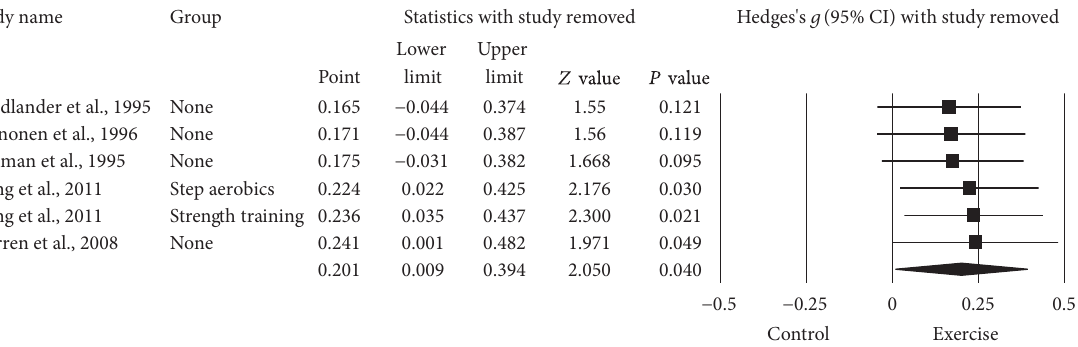
) in LS BMD with ) while the le and 𝑔𝑔 con�dence intervals. 𝑔𝑔 % (cid:2406)